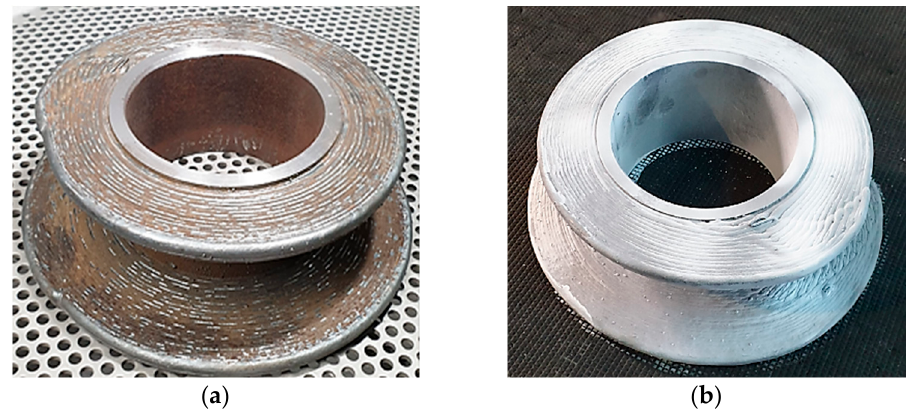
Figure 7. Sandblasting of part. ( a ) Before sandblasting ; ( b ) after sandblasting . Three-dimensional scanning (Figure 8)—The purpose of this procedure was to check